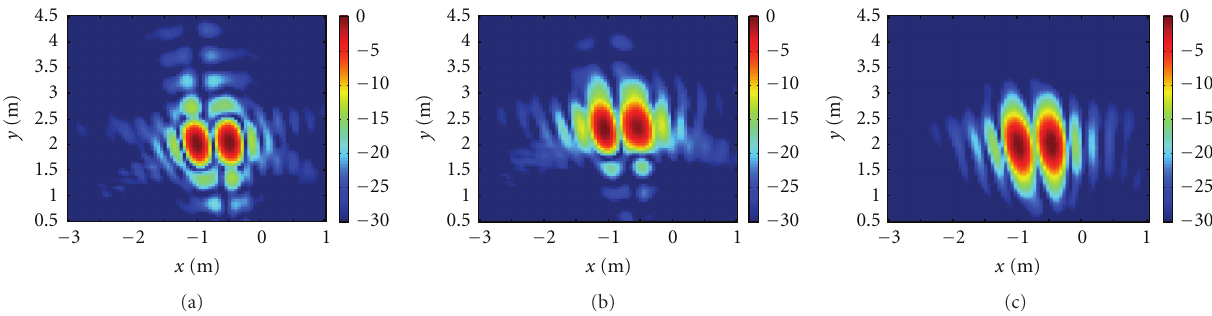
Figure 3: Back-projection images of the two point targets for the configuration in Figure 2 with data collected over the band 0.7–1.0 GHz: (a) image in free space, (b) Image in presence of the cinderblock wall using the free space Green’s function, (c) image in presence of the cinderblock wall using the periodic layer Green’s